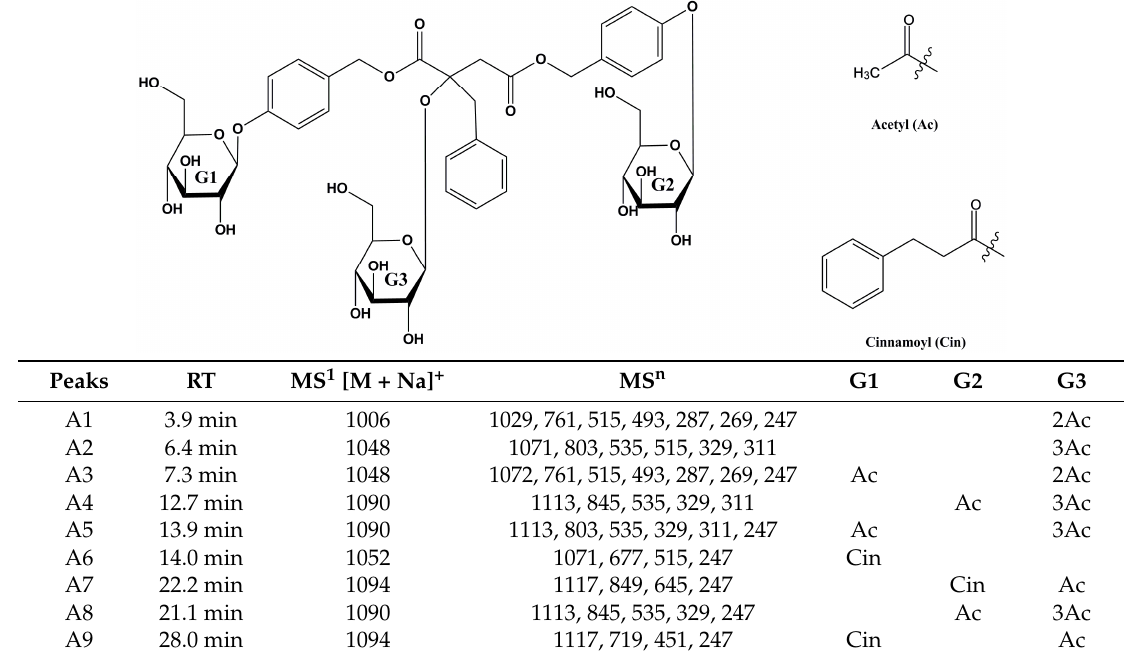
Table 4. Key ESI-MS n Fragment Ions and structural information of the components predicted.